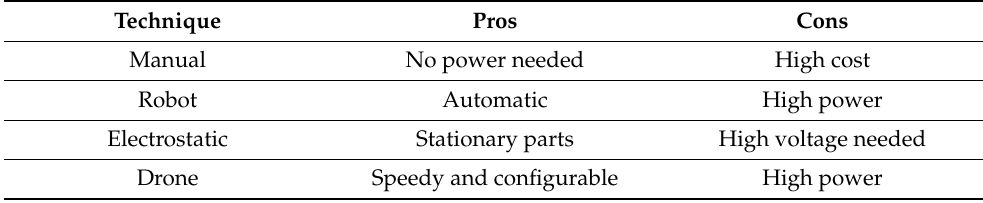
Table 1. Different PV panel cleaning techniques (pros and cons).